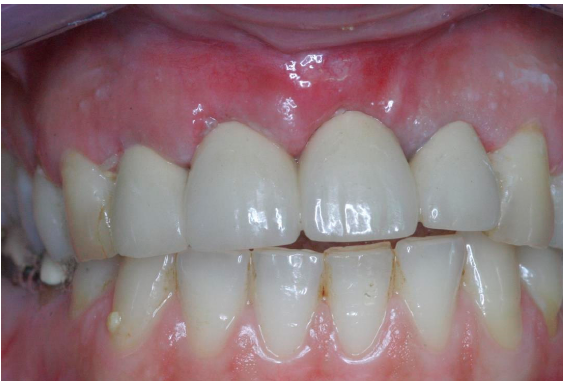
Figure 3. Pre-fabricated non-functional metallic re-enforced acrylic temporary bridge placed 48 h after implant placement.